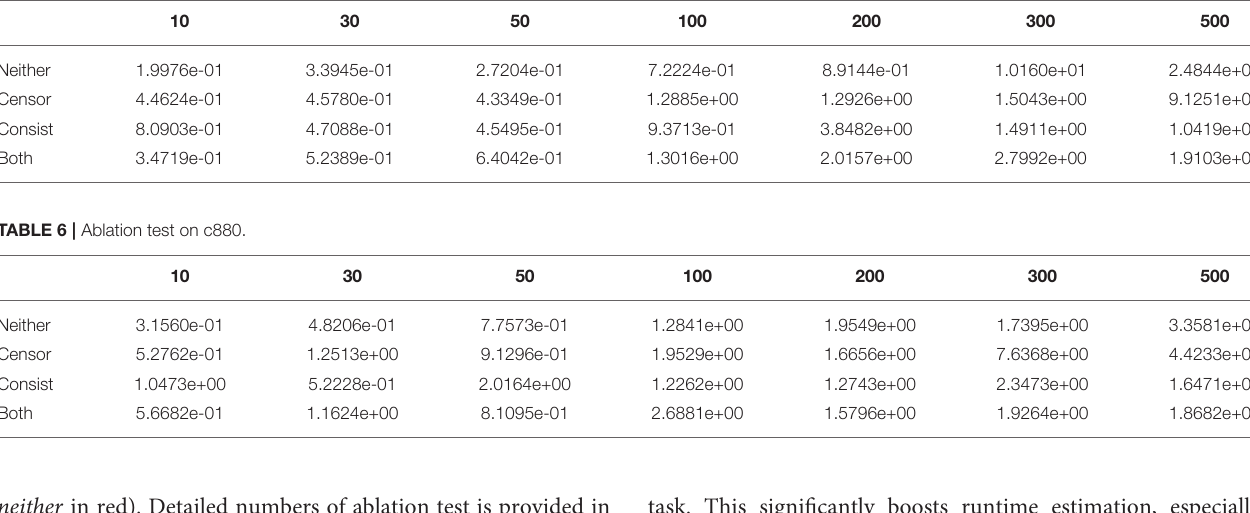
TABLE 5 | Ablation test on c499.